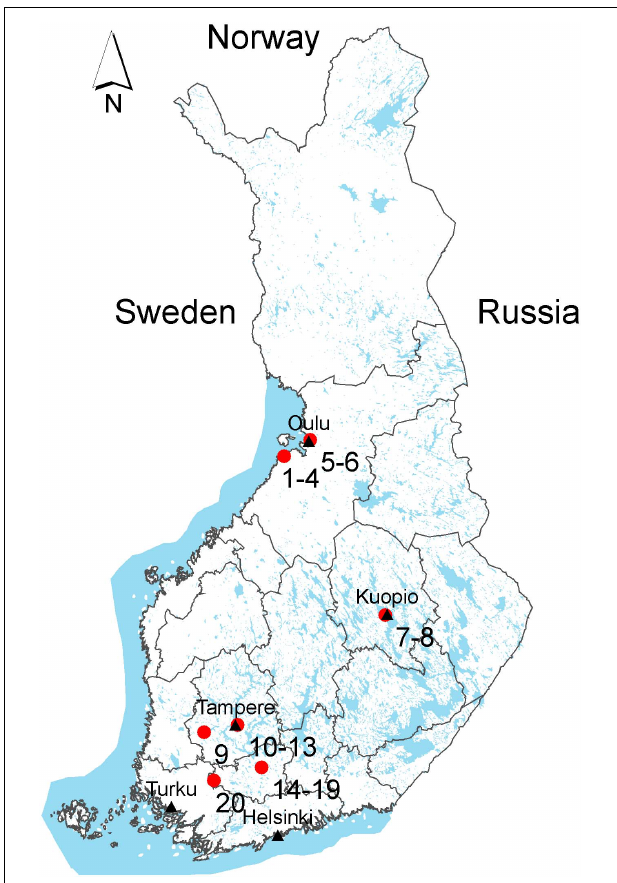
FIGURE 1 | Water sample collection sites. Sites 1–6: Northern Ostrobothnia; sites 7–8: Northern Savonia; sites 9–13: Pirkanmaa; sites 14–20: Kanta-Häme (Map: National Land Survey of Finland; Sea area: Statistics Finland, Esri Finland). Each compartments on the map denotes 18 political regions of Finland, among them our study sampling covers four political regions.